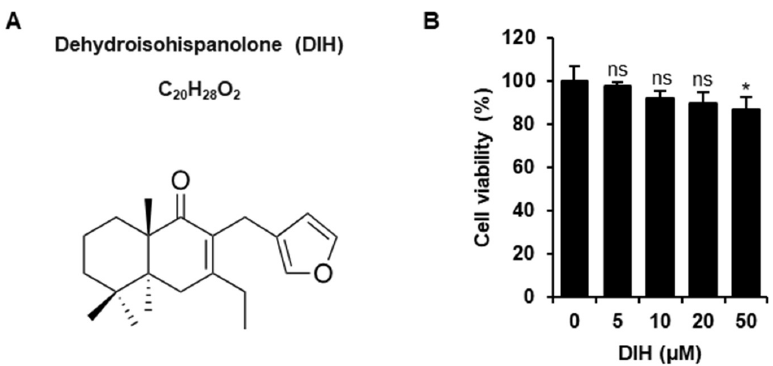
Figure 1. Chemical structure and cytotoxic effects of DIH on macrophages. ( A ) Chemical structure of dehydroisohispanolone (DIH) ( B ) J774A.1 cell viability after treatment with DIH (5–50 µ M) for 24 h was determined by MTT assay and results are reported as mean ± SD ( n = 3). ns = not significant and * p < 0.05 vs. untreated